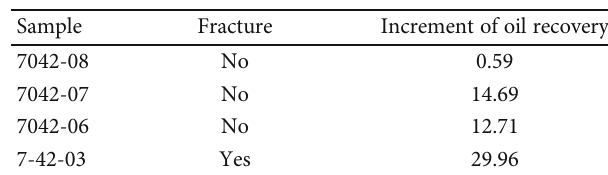
Table 2: Contrast of imbibition between fractured core and matrix